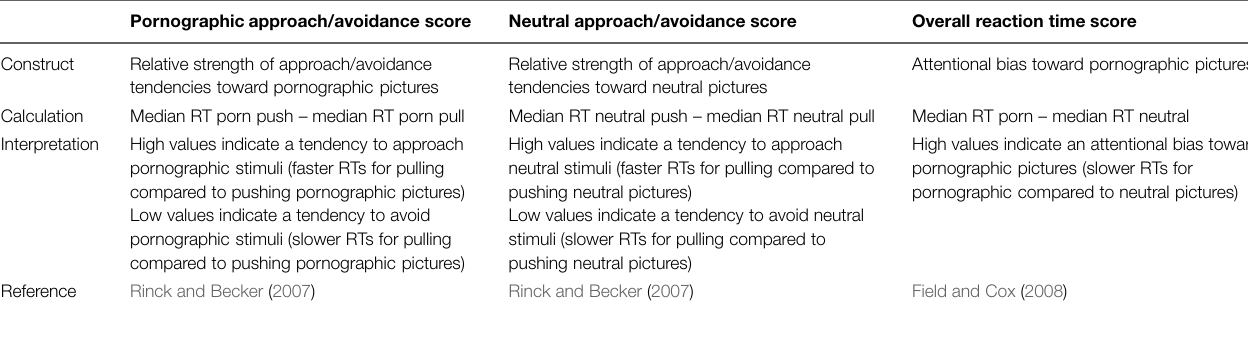
TABLE 1 | Calculation and interpretation of AAT